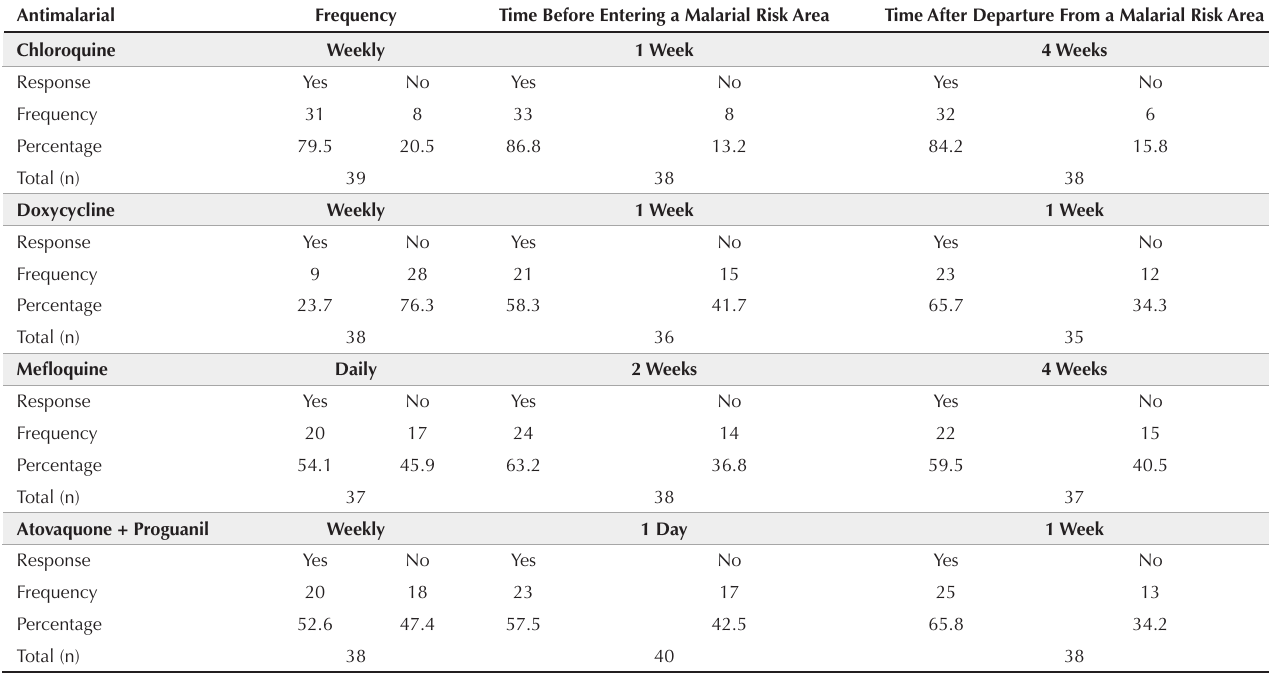
Table 6. Characteristics of Recommended Prophylactic Antimalarials in the State of Qatar Antimalarial Frequency